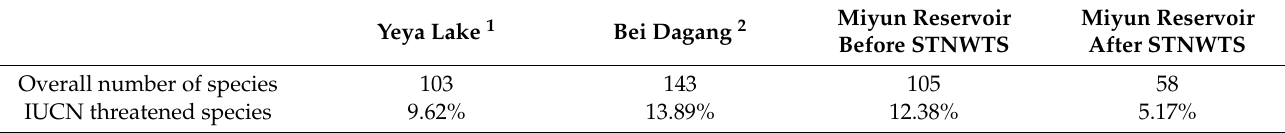
Table 4. The total species count, the percentage of IUCN endangered species, the percentage of national protected animals before and after STNWTS, and their comparison to Beijing’s Yeya Lake and Tianjin’s Bei DaGang